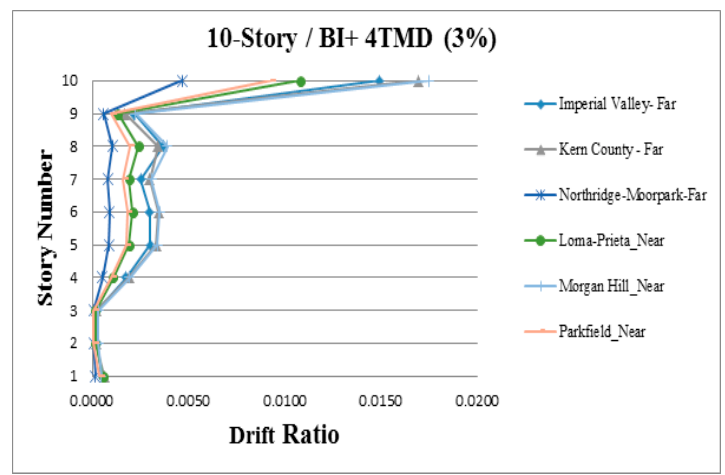
Figure 15. Drift ratios for 10-story base-isolated building with 4 TMDs.